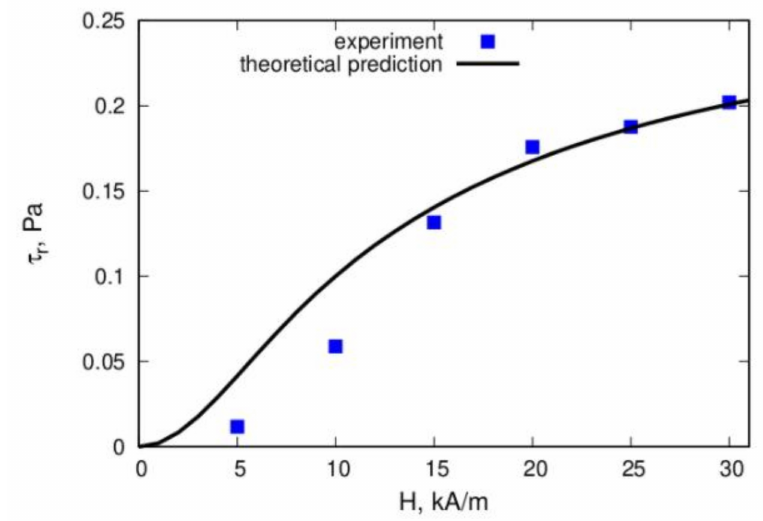
Figure 18. Comparison of the theoretical prediction and experimental results for the residual stress τ r versus the magnetic field strength. The proportion of magnetic material that was part of the bulk drops was 0.12. Details of the experiment and calculations are given in [144]. The plots were redrawn by the authors using our own raw